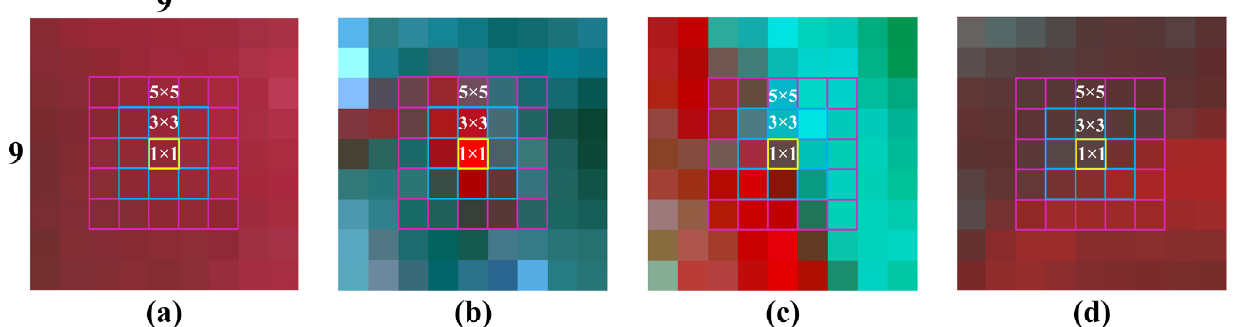
Figure 13. Effects of different receptive fields on the feature extraction of S. alterniflora . Combined images of NIR-R-G band. Bright red pixels are S. alterniflora . Three different colored grids represent convolution kernels of different sizes. ( a ) Full coverage of S. alterniflora . ( b ) Small patch of S. alterniflora . ( c ) The boundary between S. alterniflora patch and tidal flat. ( d ) Mixed zone of S. alterniflora and Suaeda .